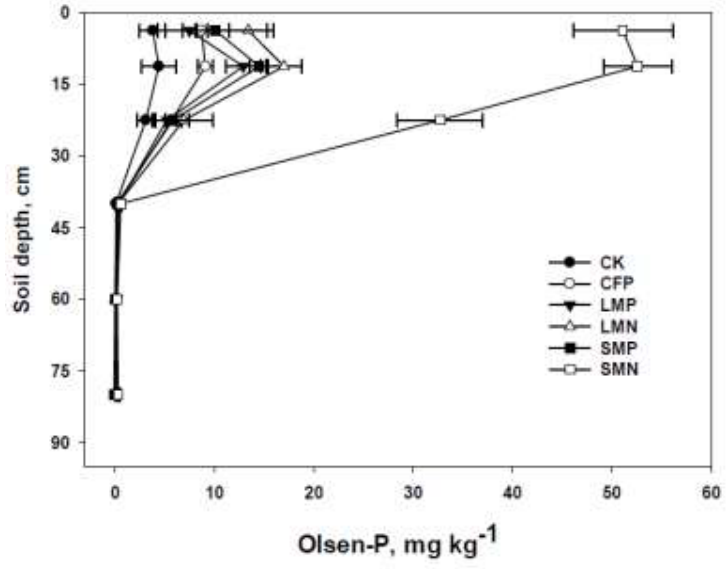
Figure 6. Postharvest soil test P (Olsen-P) content in 0–90 cm soil profile in response to various sources of P addition (chemical fertilizer vs. liquid and solid swine manures) and application approaches (P-based vs. N-based) after 10-year corn-soybean production in a clay loam soil, Woodslee, ON, Canada. Horizontal bars are standard errors ( n = 3).